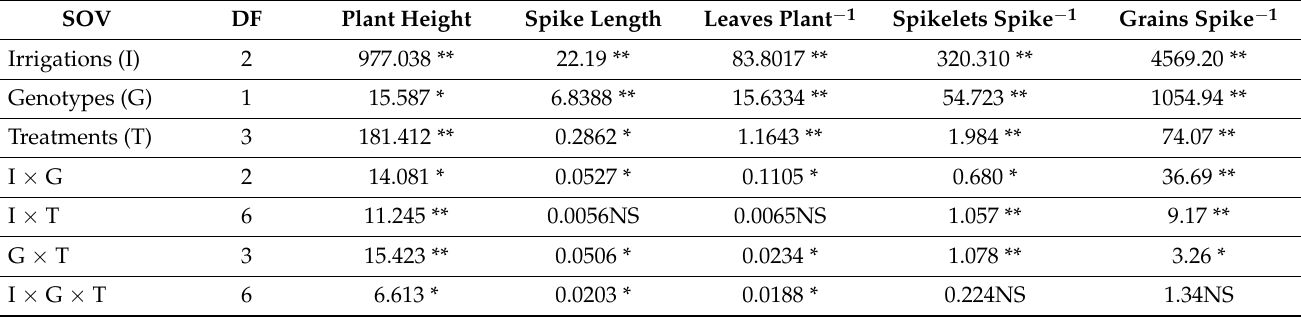
Table 2. Analysis of variance (mean sum of squares) of plant height, spike length, number of leaves per plant, number of spikelets per spike and number of grains per spike of triticale genotypes cultivated under various irrigation regimes in response to NPK and organic